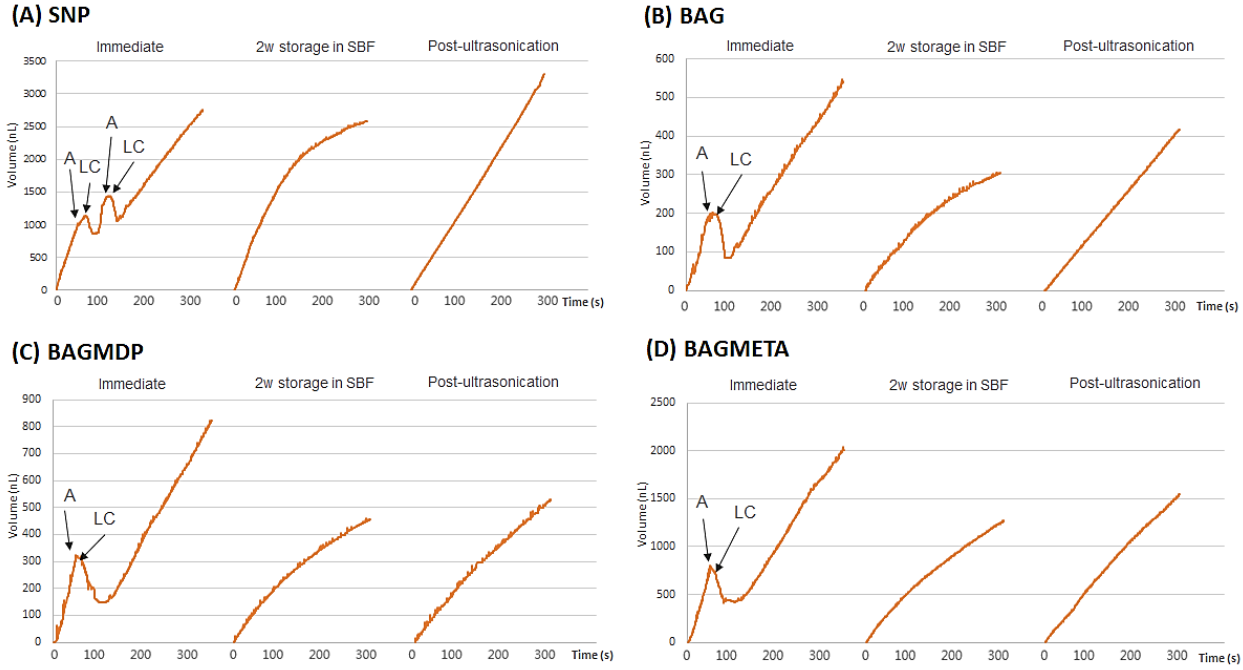
Figure 3. Representative graphs of real-time changes of DFF rate (%) of all experimental groups throughout the procedures, which consisted of the following three different timepoints: (1) before and after the application of desensitizer; (2) after the 2-week storage in SBF; (3) after